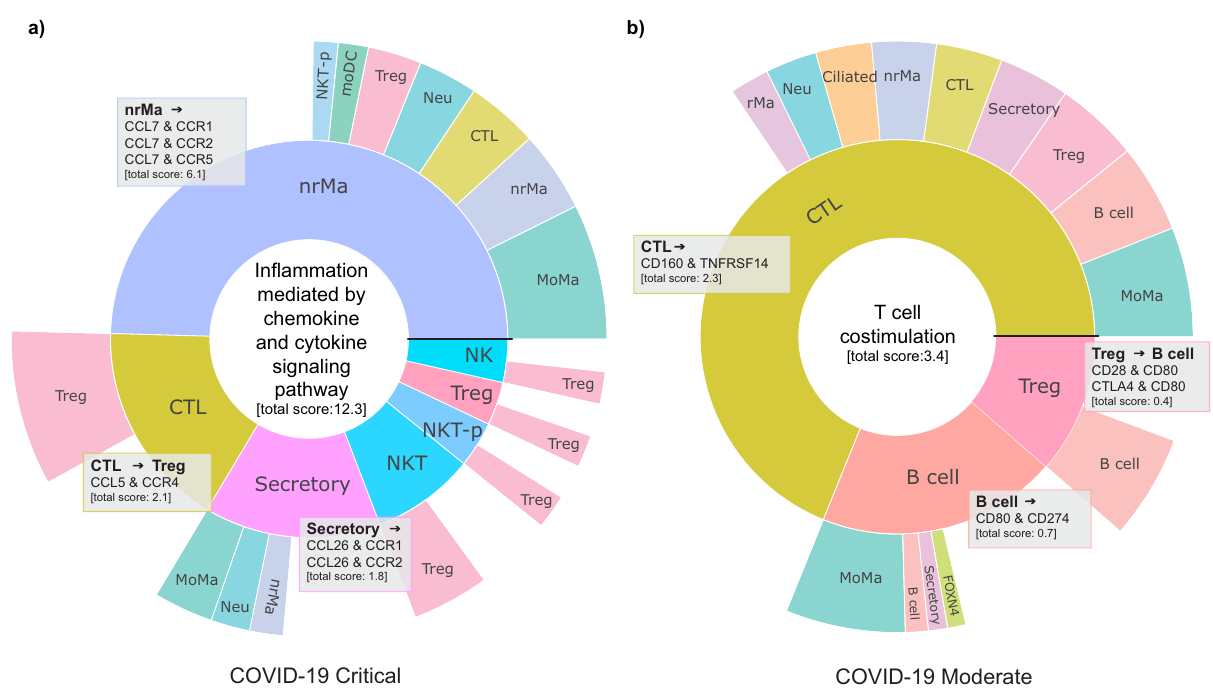
Fig. 6 Investigation of signi fi cant functional pathways and their enriched condition-speci fi c interactions. Sunburst plots for two condition-speci fi c functional terms found to be signi fi cant (one-sided permutation test, p < 0.05) in the comparison between a COVID-19 critical ( “ In fl ammation mediated by chemokine and cytokine signaling pathway ” ) and b moderate cases ( “ T cell costimulation ” ). Plots are generated in InterCellar ’ s multiple conditions module, by selecting the chosen terms from a table. Only int-pairs unique to each condition and annotated to the selected functional term are considered in the generation of the plot. For a generic int-pair ‘ geneA & geneB ’ , enriched in ‘ cluster1::cluster2 ’ , the fi rst cell cluster (cluster1, expressing geneA) is represented in the inner circle, while the second (cluster2, expressing geneB) is shown in the outer circle. The width of each section indicates the relative fraction of interactions (weighted by score) enriched in that cell type. Sections are arranged in descending order, counterclockwise, starting from the horizontal black line. The total interaction scores per cell type are reported in brackets. Gray boxes show the list of condition-speci fi c int-pairs enriched for the corresponding cluster-pairs and were manually added to the fi gure from the downloaded fi les provided by